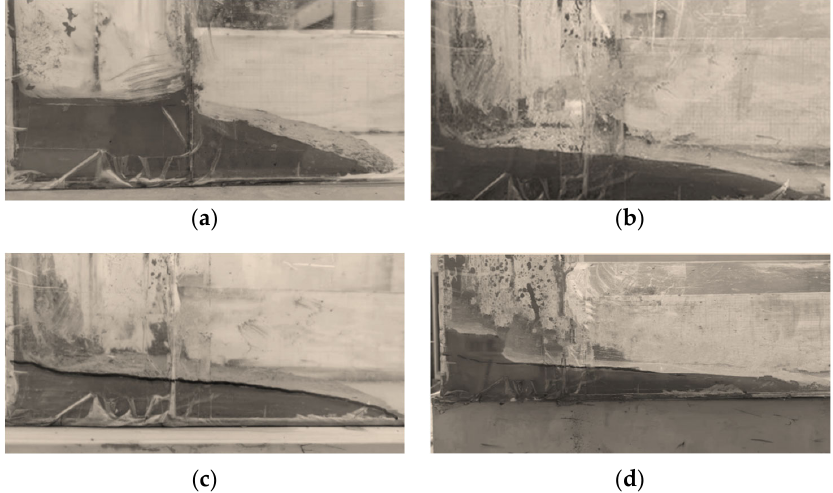
Figure 7. Preparation of all tailings paste: ( a ) 72%; ( b ) 70%; ( c ) 68%; ( d ) 66%.